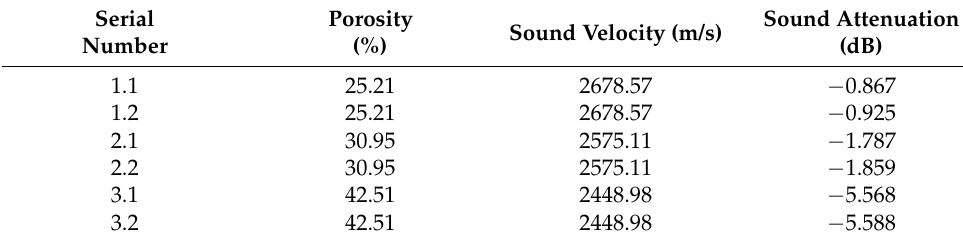
Table 3. Measurement results of sound velocity and attenuation of CRC similarity